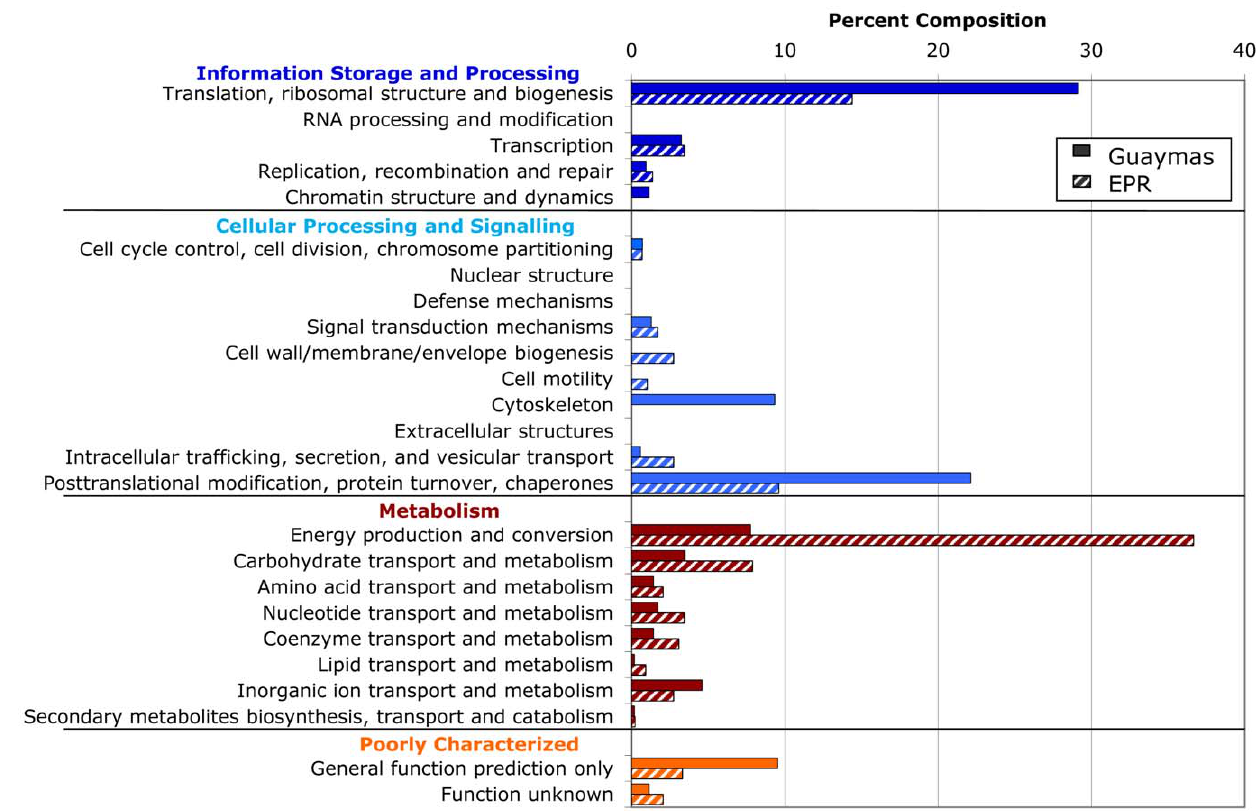
Figure 3. Upregulated proteins recovered from East Pacific Rise (EPR) and Guaymas Riftiapachyptila trophosome, categorized using Clusters of Orthologous Groups. Percent composition is with regard to number of occurrences of each protein categorical type, in each proteome. Multiple peptides that were identified as corresponding to a single protein were listed as one hit in the corresponding category.